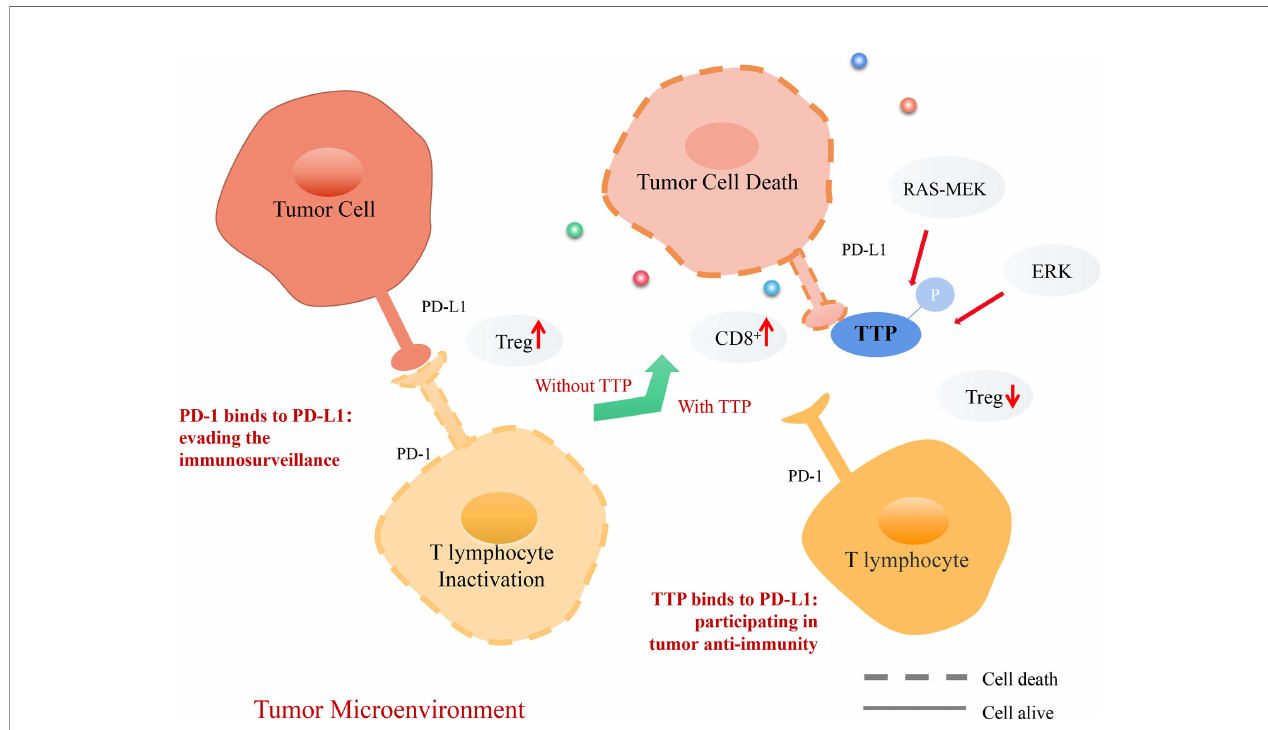
FIGURE 5 | Mechanism of TTP-dependent anti-tumor immunity in the tumor microenvironment (TME). PD-1, a receptor expressed on T lymphocytes, interacts with its ligand PD-L1 on target cells, recognizing healthy cells and preventing induced cell death. However, tumor cells can express PD-L1 and interact with PD-1 on T lymphocytes. T lymphocytes in fi ltrate Treg cells, evading the tumor immunosurveillance to allow distant metastasis. Consequently, TTP recognizes tumor cells, destabilizes PD-L1 mRNA, and decreases its expression. Thus, T lymphocytes can recognize tumor cells and secrete CD8 + cells to promote tumor cell